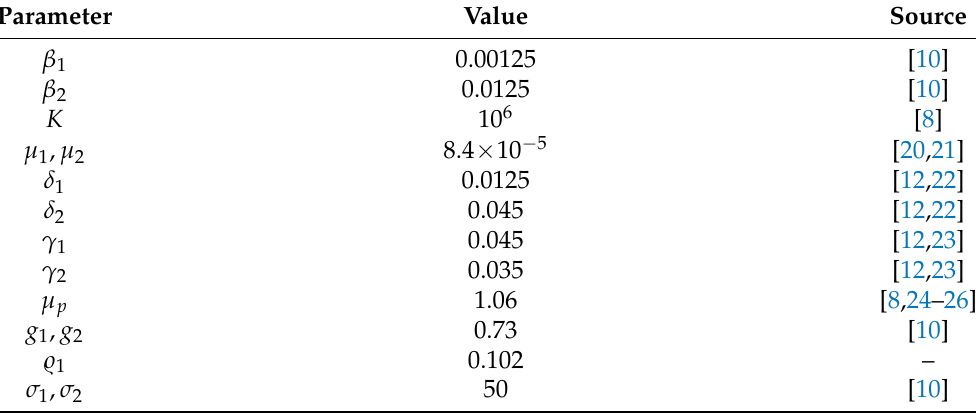
Table 1. Values of model’s parameters.